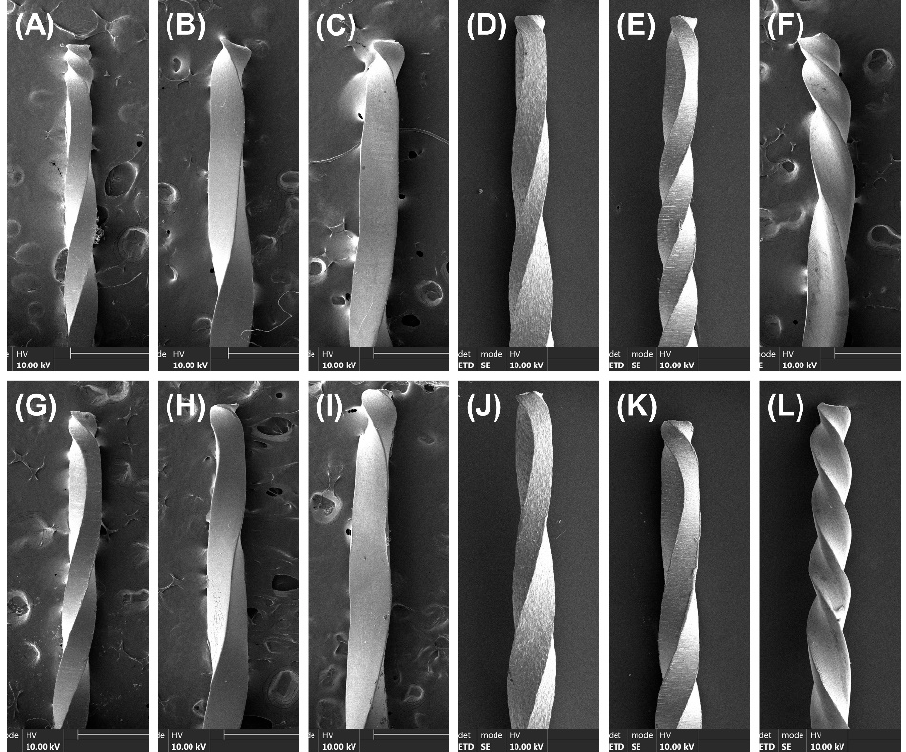
Figure 5. SEM images of the fractured instruments. Lateral surfaces of PathFile ( A ), RaCe ( B ), RaCe Evo ( C ), HyFlex EDM ( D ), TruNatomy Glider ( E ), and V Taper 2H ( F ), which fractured in straight mode. Lateral surfaces of PathFile ( G ), RaCe ( H ), RaCe Evo ( I ), HyFlex EDM ( J ), TruNatomy Glider ( K ), and V Taper 2H ( L ), which fractured in flexural mode. Plastic deformation included unwinding and overwinding of instruments (original magnification ×100).